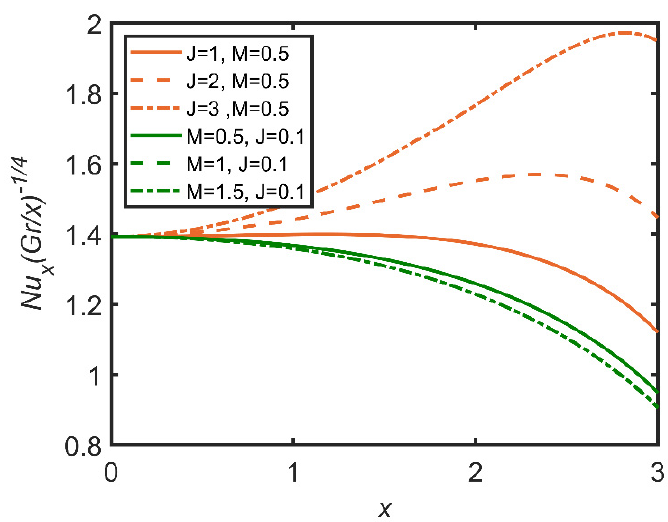
Figure 22. Comparison for Nusselt number against x.